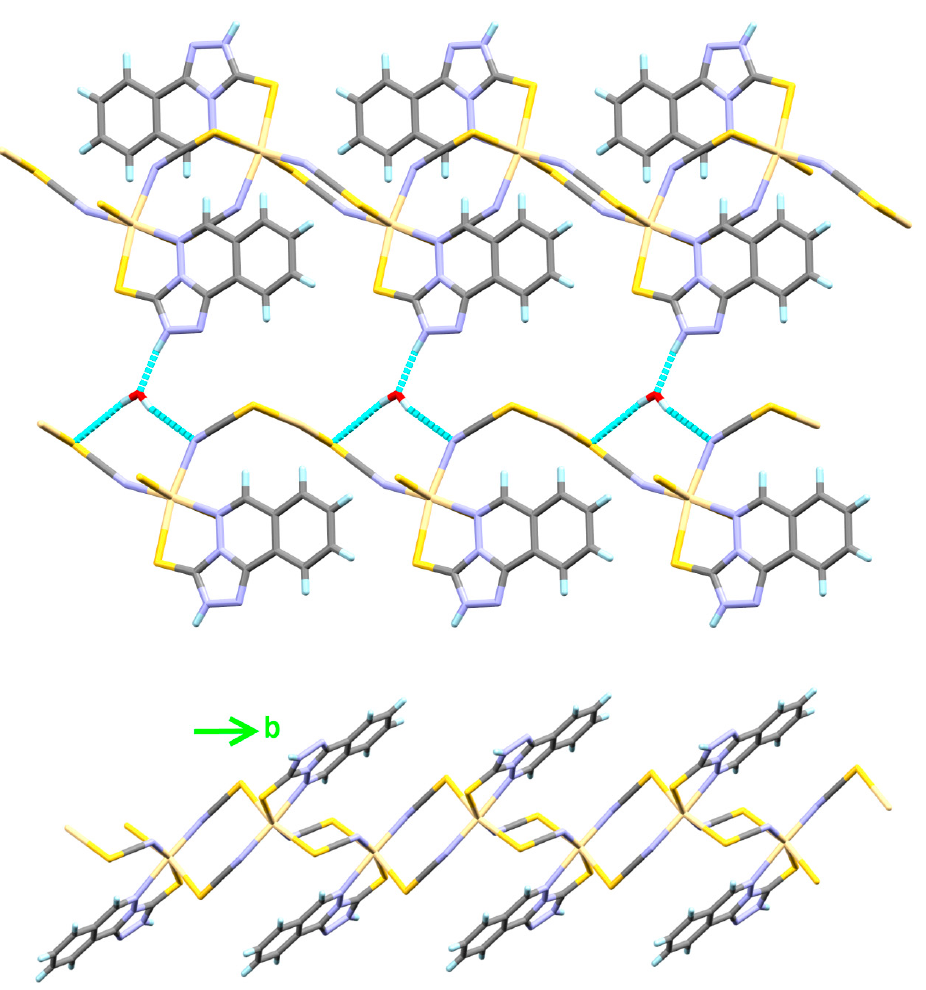
Figure 7. The 1D coordination polymer ( lower ) and the interconnected 1D chains via the hydrogen bonding interactions with the crystal water molecules leading to the 2D supramolecular structure.